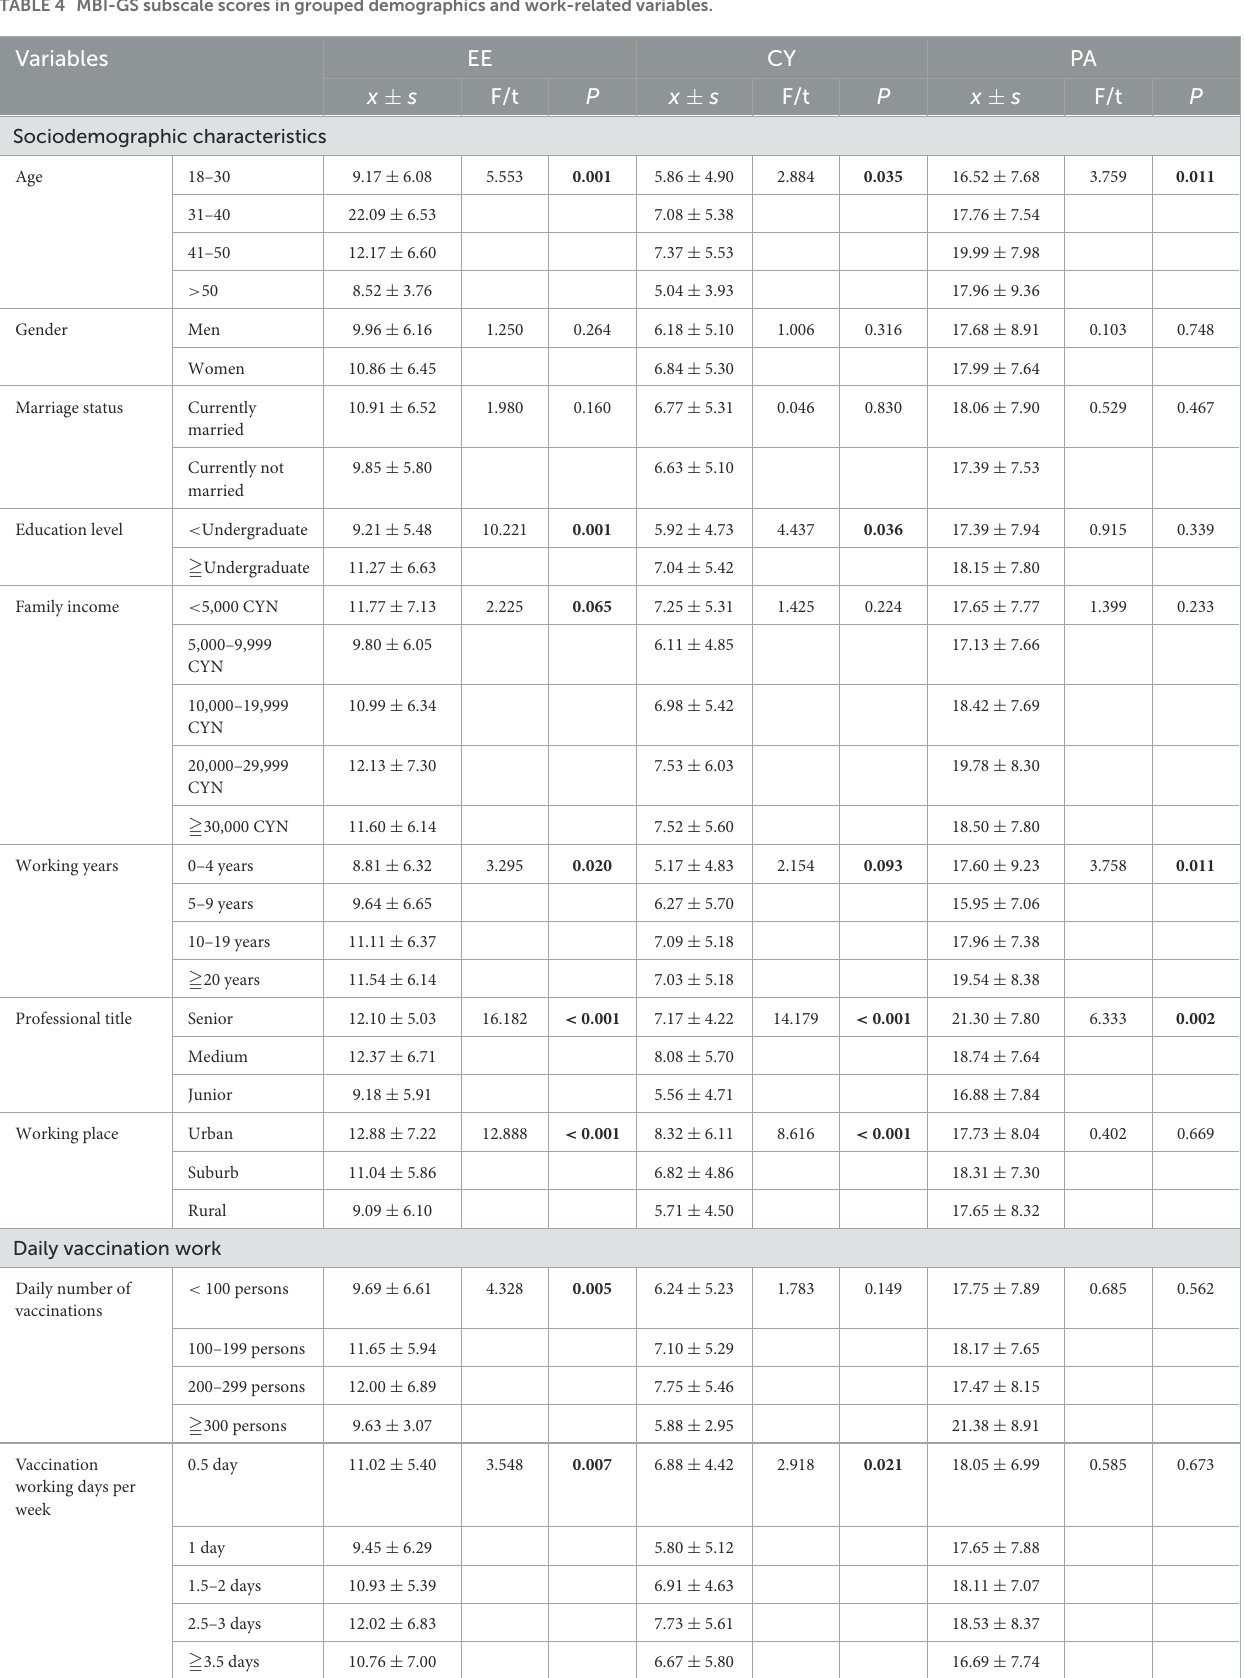
TABLE 4 MBI-GS subscale scores in grouped demographics and work-related